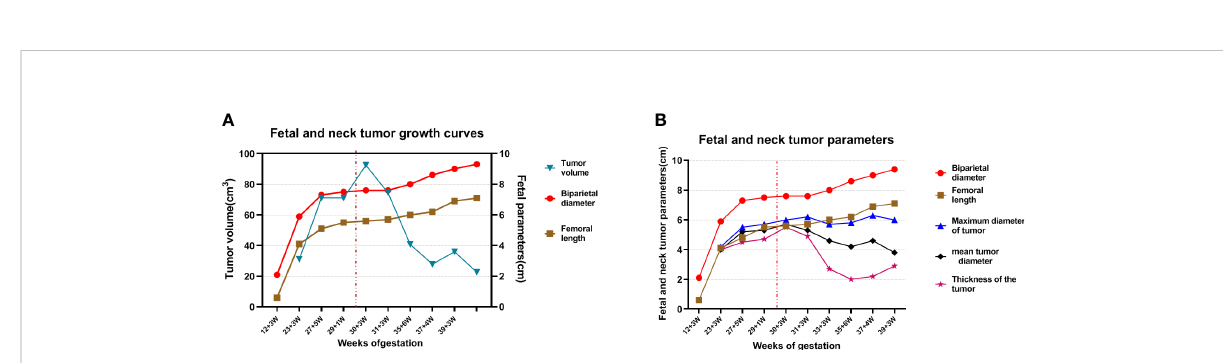
FIGURE 3 Fetal and neck tumor growth curves. “… in red ” indicates the time that the fetus received intrauterine treatment. (A) The red curve: biparietal diameter; brown curve: fetal length; blue curve: tumor volume; (B) red curve: biparietal diameter; brown curve: fetal length; blue curve: maximum tumor diameter; black curve: mean tumor diameter; purple curve: tumor